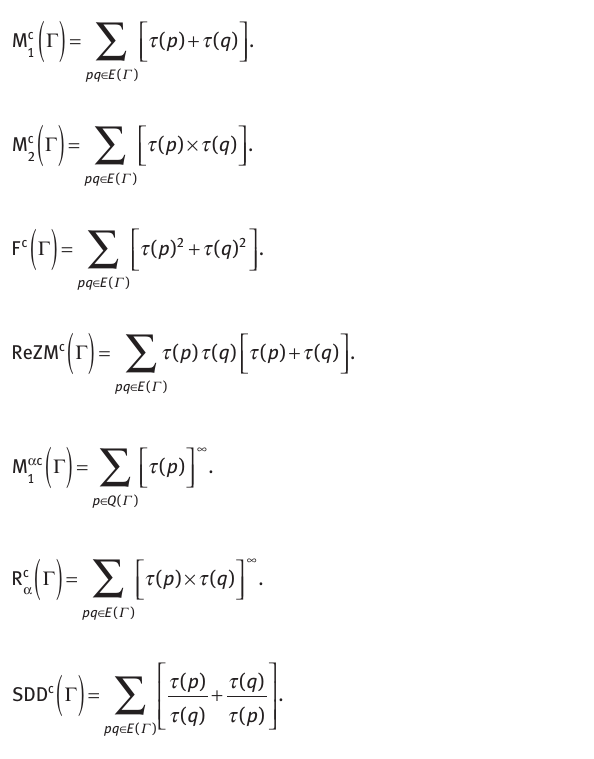
Table 3: Zagreb connection indices.